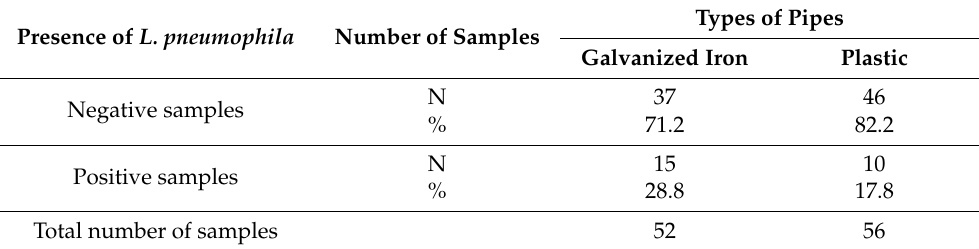
Table 1. Display of negative and positive findings of Legionella spp. in water samples collected from hotels with different type of pipes.